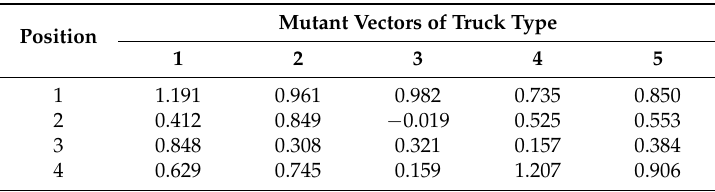
Table 9. Mutant vectors of truck type.